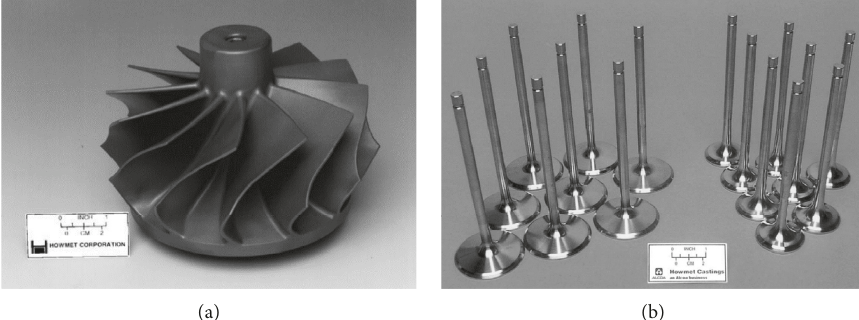
Figure 2: (a) Turbine wheel casting of c -TiAl for automotive turbochargers by Howmet Corporation. (b) Cast c -TiAl exhaust valves in testing for high-performance cars